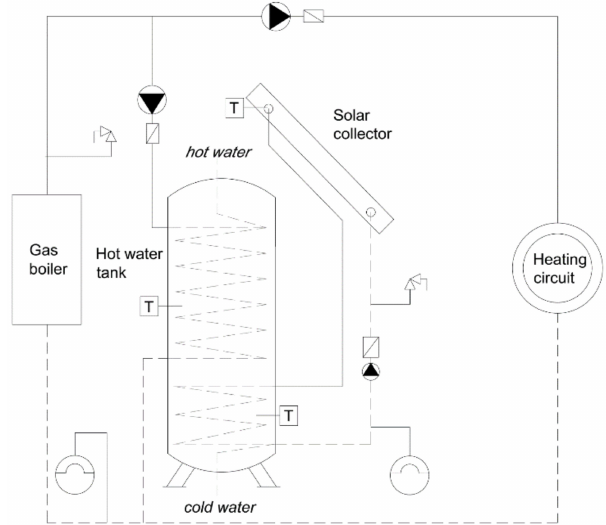
Figure 4. Hydraulic diagram of calculation Variant 1.